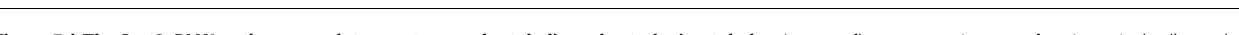
Figure 5 | The Stat3–PLK1 pathway regulates centrosomal c -tubulin and astral microtubules. Immunofluorescence images of pericentrin (red), g -tubulin (green) and Hoechst (blue) in mitotic supernumerary centrosome BT-549 cells treated with Stattic ( a ) or BI-2536 ( b ). Graphs of line scans (right panels), dashed white lines denote the scanned area, arrows point to centrosomes. Scale bar, 3 m m. ( c ) Quantification of fluorescence intensities of g -tubulin in mitotic cells treated with Stattic or BI-2536 (top) or Stat3 siRNA and Stat3C or Stat3-Y705F (bottom). Data points (circles). Centre lines (medians). Box limits indicate the 25th and 75th percentiles. Whiskers extend 1.5 times the interquartile range from the 25th and 75th percentiles. n ¼ 15 biological replicates. Statistical significance was tested between control and treated groups with analysis of variance (ANOVA). ( d ) Western blot of g -tubulin siRNA-treated BT-549 cells stained for g -tubulin and GAPDH (loading control). ( e ) Quantification of the mitotic spindle morphologies of g -tubulin siRNA-treated mitotic BT-549 cells with two centrosomes (left) or supernumerary centrosomes (right). n ¼ 5 biological replicates, 100 cells per condition. Statistical significance was tested between non-specific and g -tubulin siRNA-treated groups with ANOVA. ( f ) Immunofluorescence images of a -tubulin (green), g -tubulin (red) and DNA (Hoechst, blue) in mitotic BT-549 cells with normal centrosome number that have been treated with dimethylsulphoxide (DMSO; top) or Stattic (bottom). Magnified areas show astral microtubules. Scale bar, 3 m m. ( g ) Quantification of the percentage of normal (two centrosome) mitotic BT-549 cells with long astral microtubules. * P o 0.05; ** P o 0.01; *** P o 0.001. Error bars represent s.e.m.